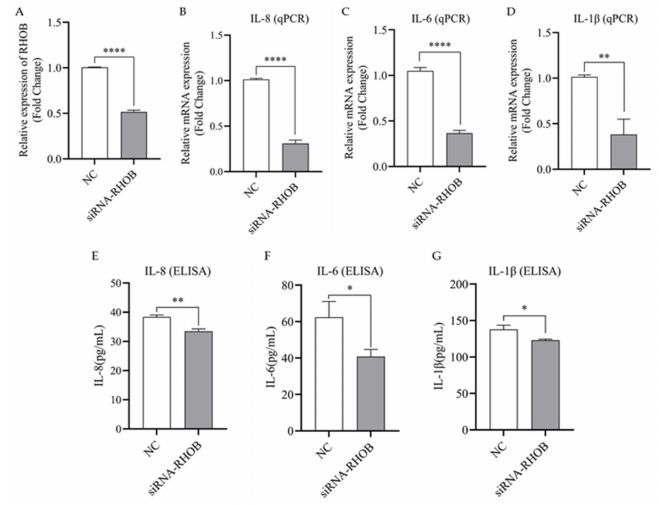
Figure 6. Expression changes of inflammatory factors after silencing of target gene RHOB. ( A ) RHOB silencing efficiency assay: cells were then collected and the expression of IL-8 ( B , E ), IL-6 ( C , F ) and IL-1 β ( D , G ) at mRNA and secreted protein levels were examined. The bMECs were transfected with RHOB small interfering fragments. bMECs were stimulated with LPS for 6 h after transfection for 42 h. The expression of inflammatory factors at the mRNA and secreted protein levels in each group of cells were measured by qPCR and ELISA, respectively. The experimental results are displayed as the mean ± SEM. * p < 0.05, ** p < 0.01, **** p <